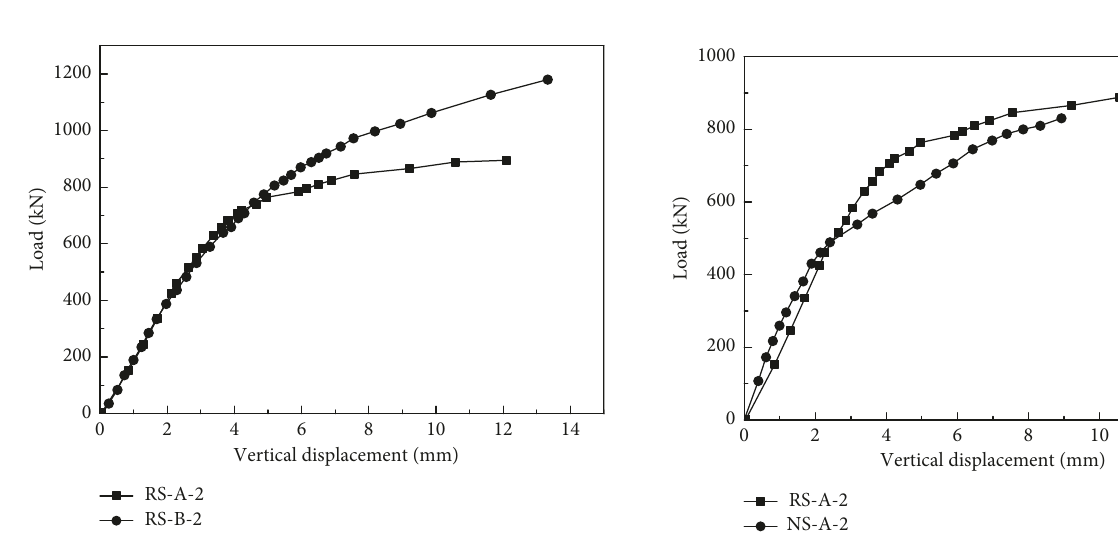
Figure 8: Comparison of reinforced and unreinforced CFST piles with thickness is 1.2